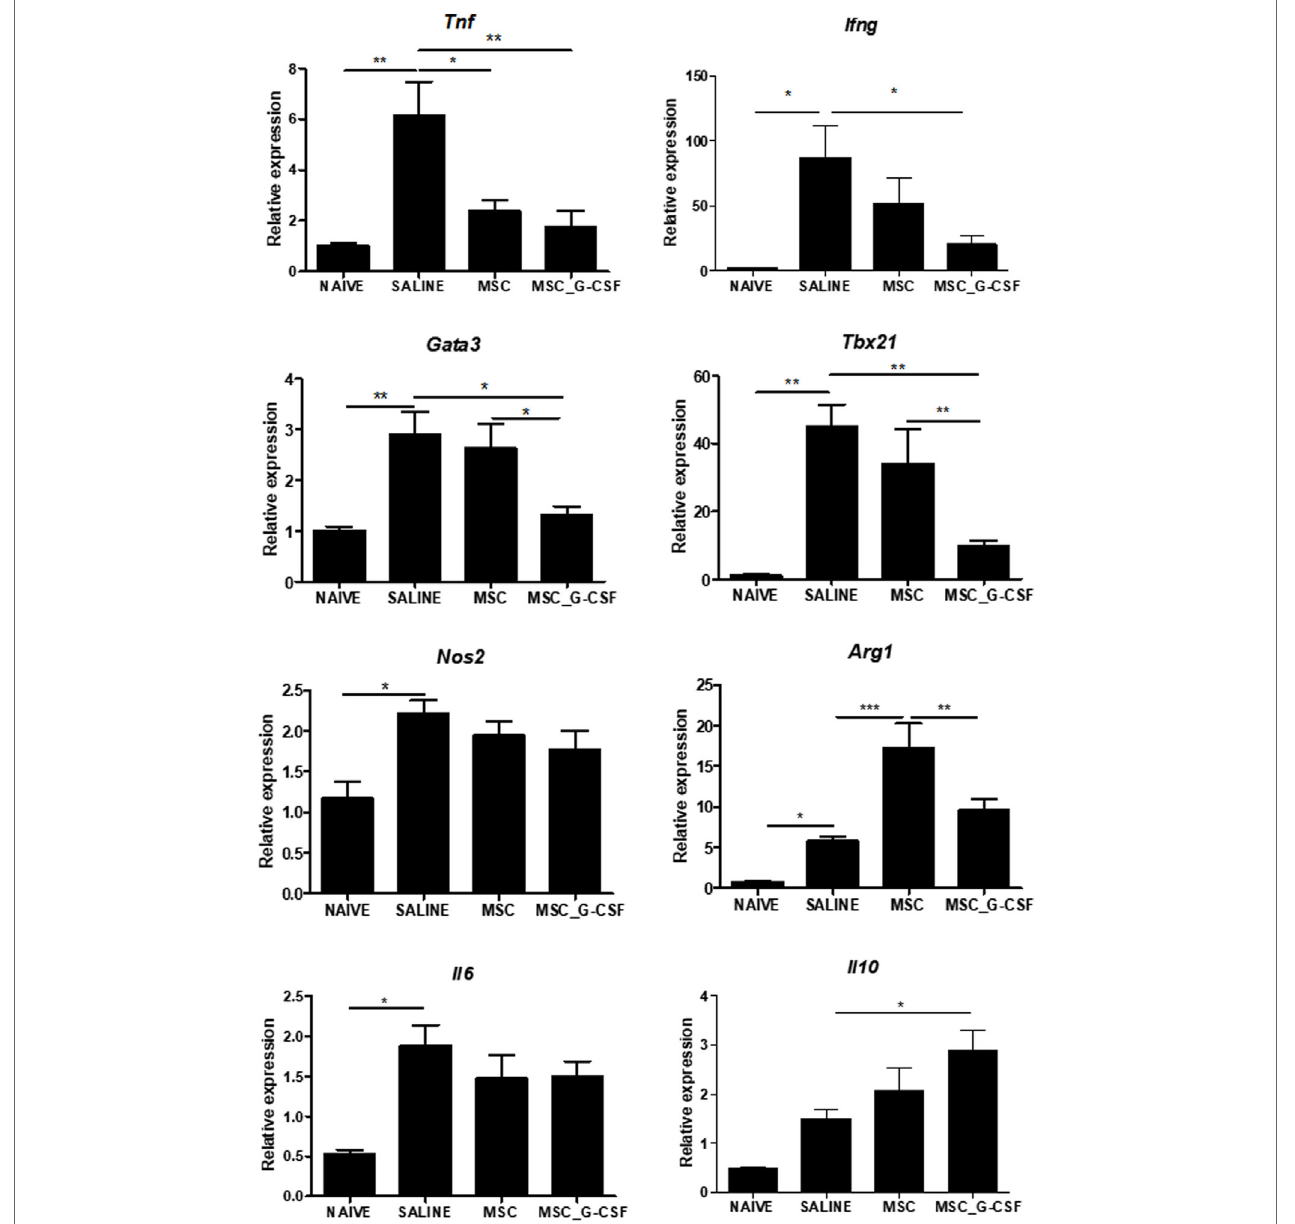
FigUre 7 | Modulation of gene expression for inflammatory mediators in the hearts of mice transplanted with MSC_G-CSF. Hearts from naïve and Trypanosoma cruzi -infected mice treated with mesenchymal stem cells, MSC_G-CSF, or saline were submitted to RT-qPCR analysis for evaluation of the gene expression for TNF α , IFN γ , GATA3, Tbet, iNOS, Arg, IL-6, and IL-10. Results are shown as relative expression to GAPDH. Values represent the mean ± SEM of 5–7 mice/group. * P < 0.05; ** P < 0.01; *** P <